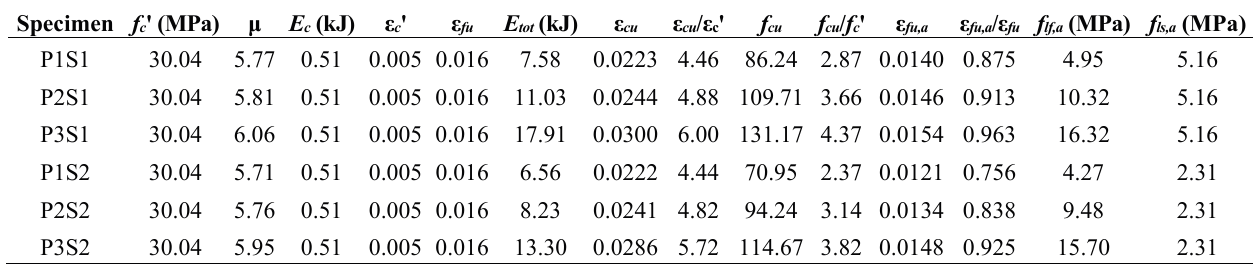
Table 3. Results of confined concrete cylinder specimens (150 mm × 300 mm).